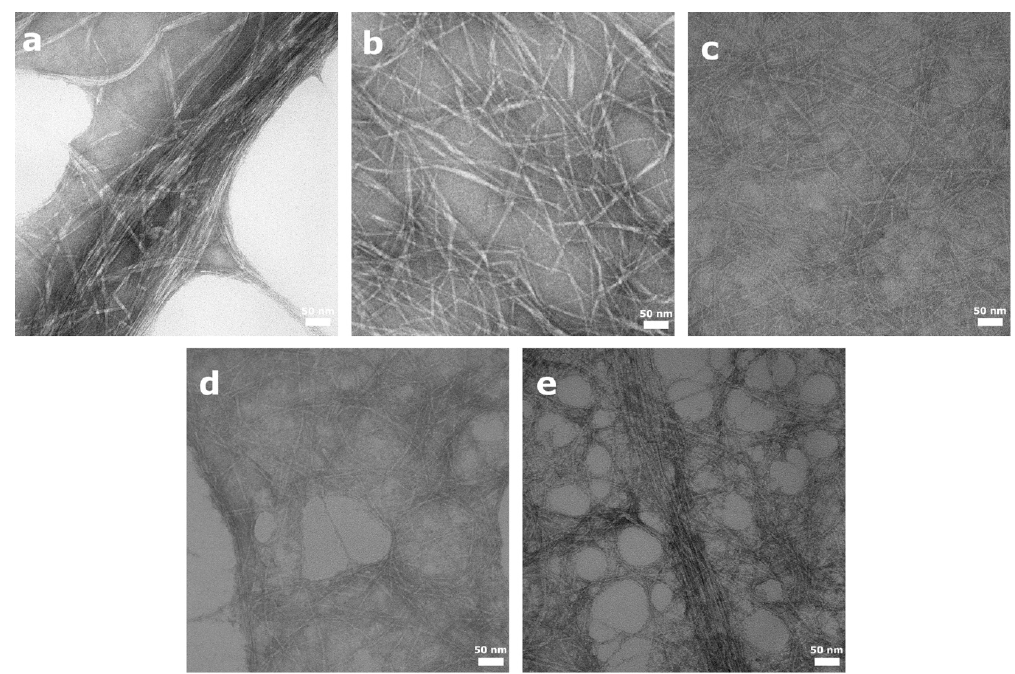
Figure 2. Representative TEM images of nanofibrillated cellulose (NFC) aqueous suspensions showing the morphology of the nanofibers. ( a ) U-NFC, ( b ) C-NFC, ( c ) H-NFC, ( d ) P-NFC and ( e ) S-NFC.